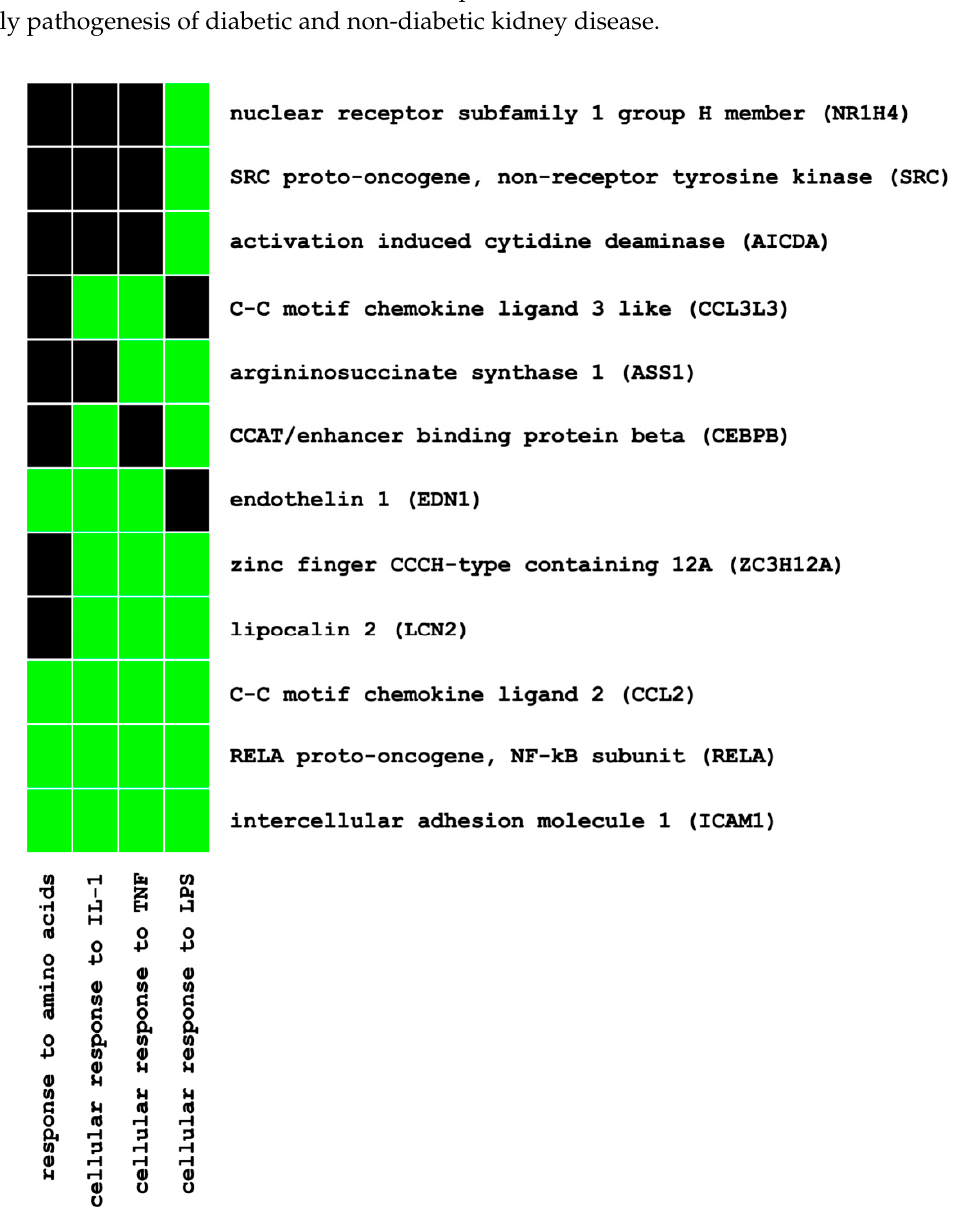
Figure 1. Functional annotation of differentially expressed genes using pathway enrichment analysis (DAVID): gene–pathway relationships of the highest ranked pathway cluster (enrichment score, 3.51). Established (= green) and unknown (= black) gene–pathway relationships.